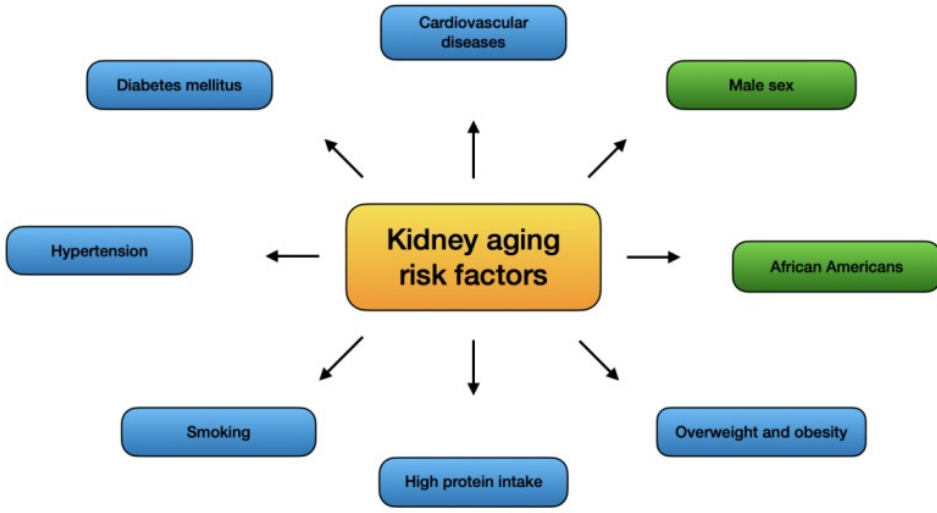
Figure 1. Risk factors of kidney aging.